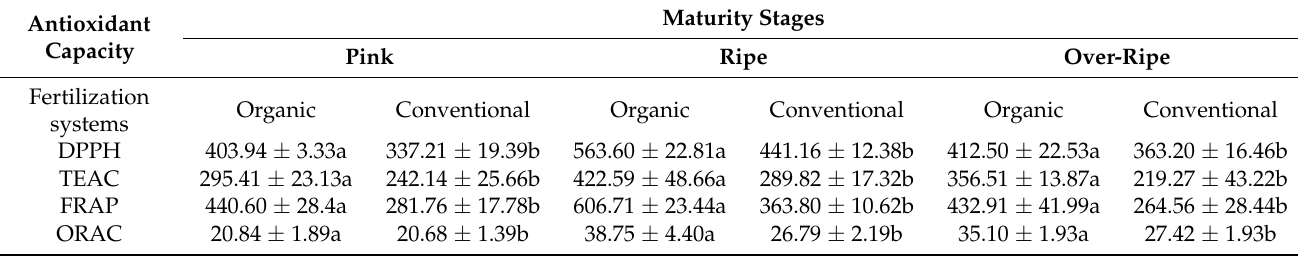
Table 6. Antioxidant capacity of raspberry fruits in three stages of maturity with organic versus conventional fertiliza- tion